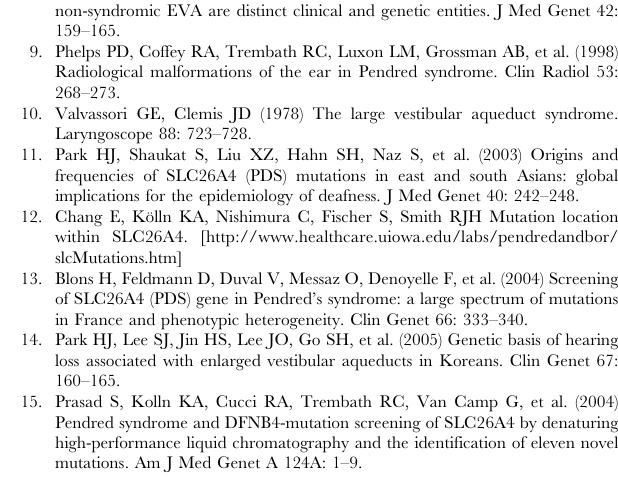
Figure S5 Heterologous expression of wild-type and mutant pendrins. HEK cells were transfected with each plasmid of the 10 variants tagged by EGFP. A membrane-based dye (orange color), di-8-ANEPPS, was also added in the solution before confocal microscopy. Co-localization of EGFP expression and the di-8-ANEPPS dye in the membrane would suggest proper membrane targeting of the proteins. (TIF) Figure S6 Transport activity of wild-type pendrin and 10 mutant pendrins. (TIF) Methods S1 SLC26A4 Site-Directed Mutagenesis Prim- ers. The mRNA from normal human adenoid specimens was extracted, and cDNA was synthesized. PCR was done to catch the target gene. Primers were as follows: Xho I -F:5 9 - CCGCTCGA- GATGGCAGCGCCAGGCGGCAG GGGGTACCGTGGATGCAAGTGTACGCATAG -3 9 Xho I -F contains protective base and XhoI restriction sites, its 5 ’end partial sequence for PCR amplify target gene. KpnI -R contains protective base and KpnI restriction sites,its 3 ’end partial sequence for PCR amplify target gene. The entire ORF of the human SLC26A4 gene was cloned into the expression vector pEGFP-N1 (Invitrogen, Carlsbad, CA, USA). The point mutation- specific primers were synthesized as shown in Table S1. Table S1 SLC26A4 Site-Directed Mutation